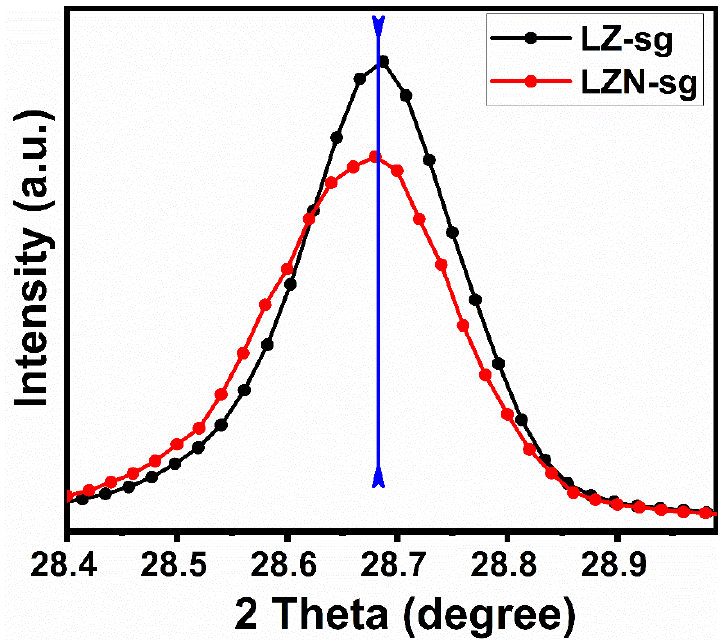
Figure 4. XRD patterns of La 2 Zr 2-x O 7 (x = 0.0 and 0.5) oxides corresponding to the (222) hkl plane.